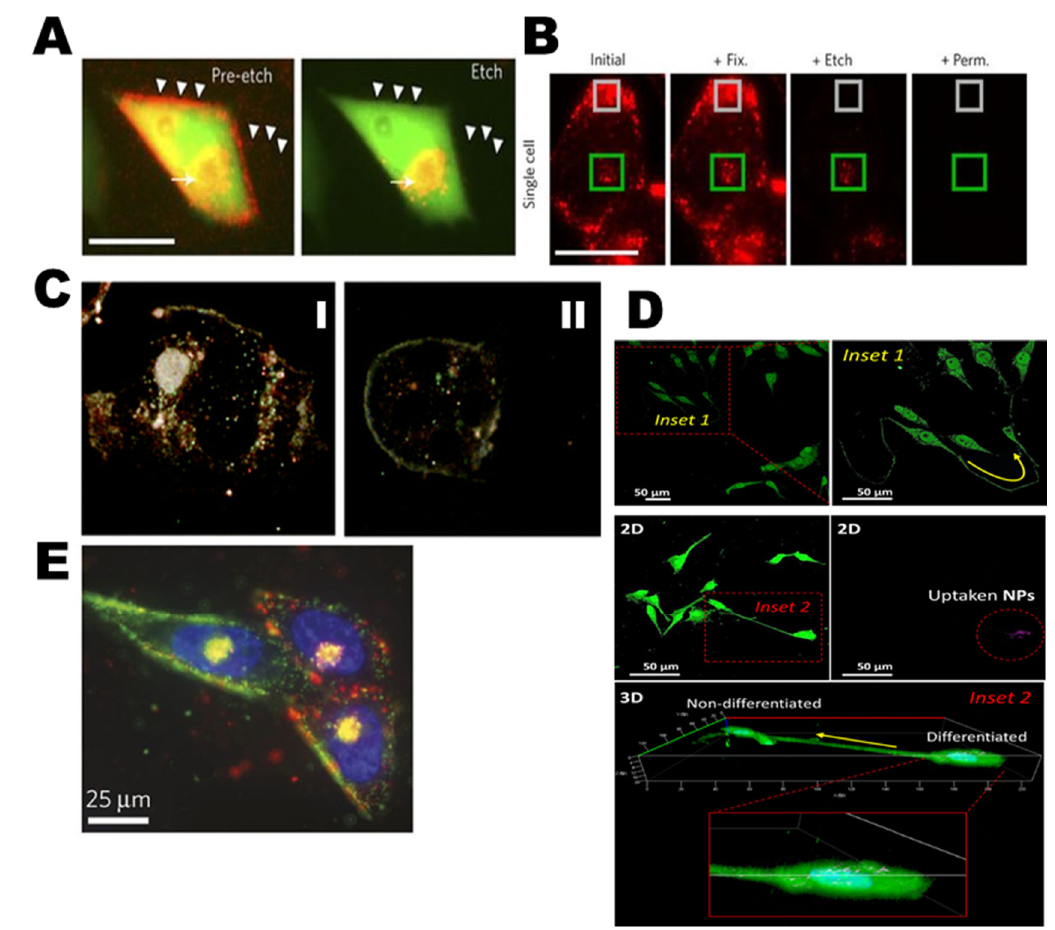
Figure 5. A schematic representation of the intracellular tracking, bioimaging, and drug delivery of AgNPs in the cancer microenvironment. ( A ) Bioimages of GFP-expressing PC-3 cells (green) when attaching and endocytosis of R-Ag-NA555 (red) has shown. The cell expresses the NRP-1 receptor. R-Ag-NA555 seems red when not correlated with the GFP in cells, and these were eliminated via etching (arrowheads). Cellular nuclei have been stained with a fluorescent dye (Hoescht blue). Yellow color signifies cellular correlation with R-Ag-NA555 due to the spatial overlap with the cellular environments, shown by the full arrows. ( B ) At the single-cell level, sequential bioimaging of fixing ( + Fix), etching ( + Etch), and permeabilization ( + Perm) in PC-3-GFP cells with exposure of R-Ag-NA555 have been analyzed. Drug delivery of internalized R-Ag-NA555 that were in cellular microenvironments (green boxes) and areas of attached but external particles (grey boxes) are exhibited. Reprinted with permission from Reference [82], Copyright 2014 Nature. ( C ) Optical bioimages of single cells show AgNPs accumulated in both the cytoplasm ( C-I ) and nuclei ( C-II ) of the cell. Adapted from Reference [83], Copyright 2010 Royal Society of Chemistry. ( D ) The two ways of cell-to-cell distinction after Ag@Bi2Se3 / PVP-3WJ-RA / R transfection. The yellow arrows show the di ff erentiation tracks; Inset 2 shows the 3D image of the cell-to-cell interaction along with a high magnitude image to display the NPs’ locations inside the di ff erentiated cells. Panel reprinted with permission from Reference [100], Copyright 2019 American Chemical Society. ( E ) PPC-1 cells have been incubated with the mixture of green and red Ag-NA (AgNPs coated NeutrAvidin-PEG-thiol), holding Lyp-1 and RPARPAR peptides, respectively. The variation of attachment among the cells may expose receptor-specific binding with colocalization in endosomes. This may occur very near to the nucleus (Hoescht, blue). Reprinted with permission from Reference [82], Copyright 2014